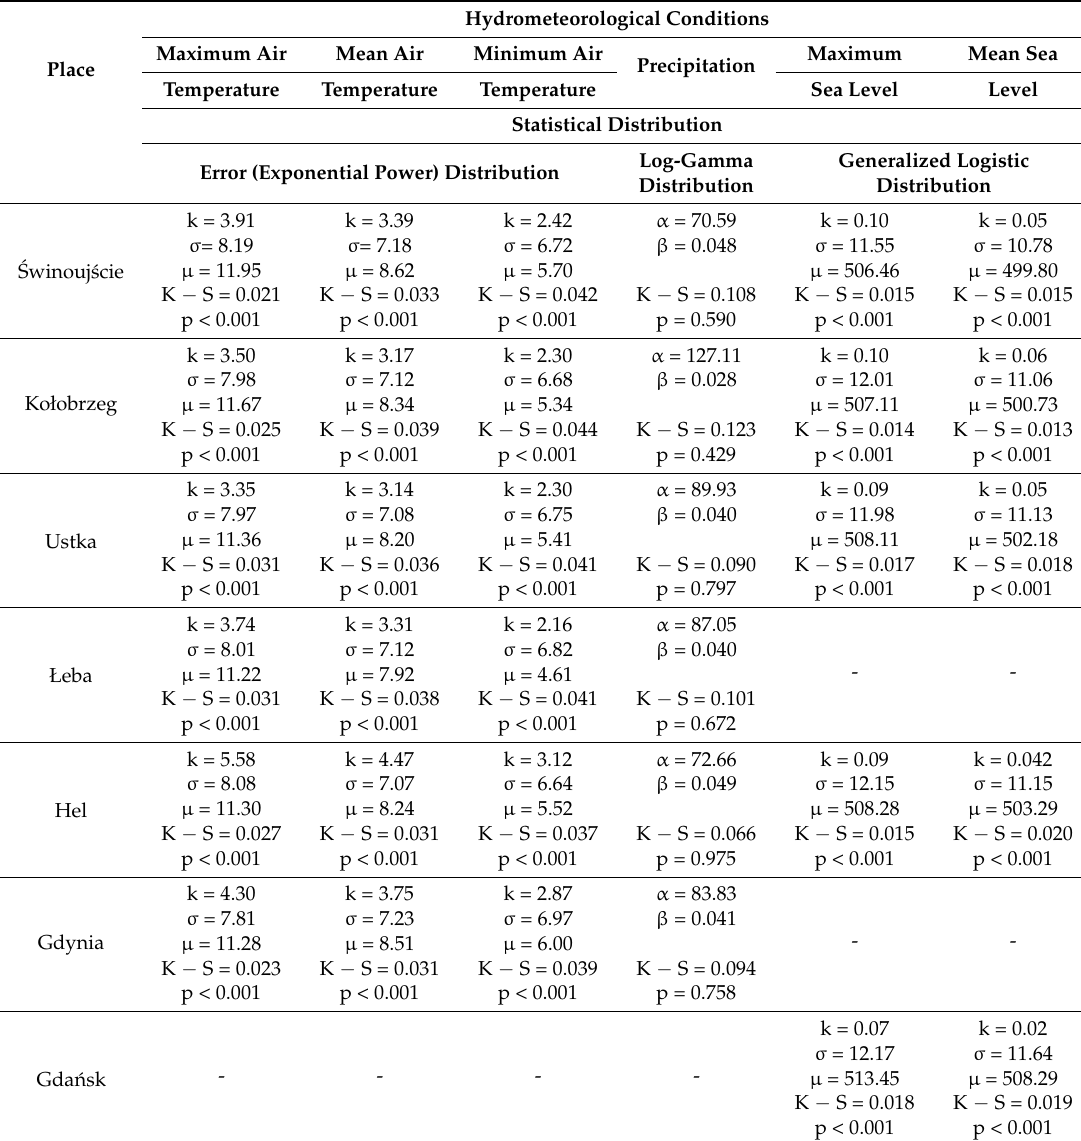
Table 2. Matching theoretical distributions to empirical data (using the K − S test) on thermal conditions, precipitation conditions, and sea level in the Polish coastal zone of the South Baltic